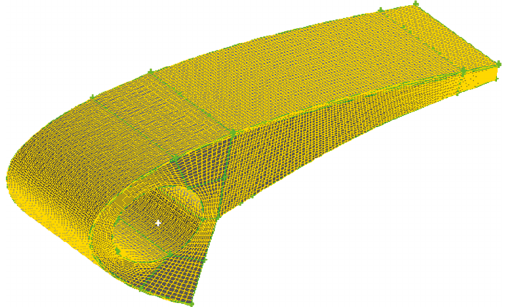
Figure 2: Overall anti-icing cavity grid model.